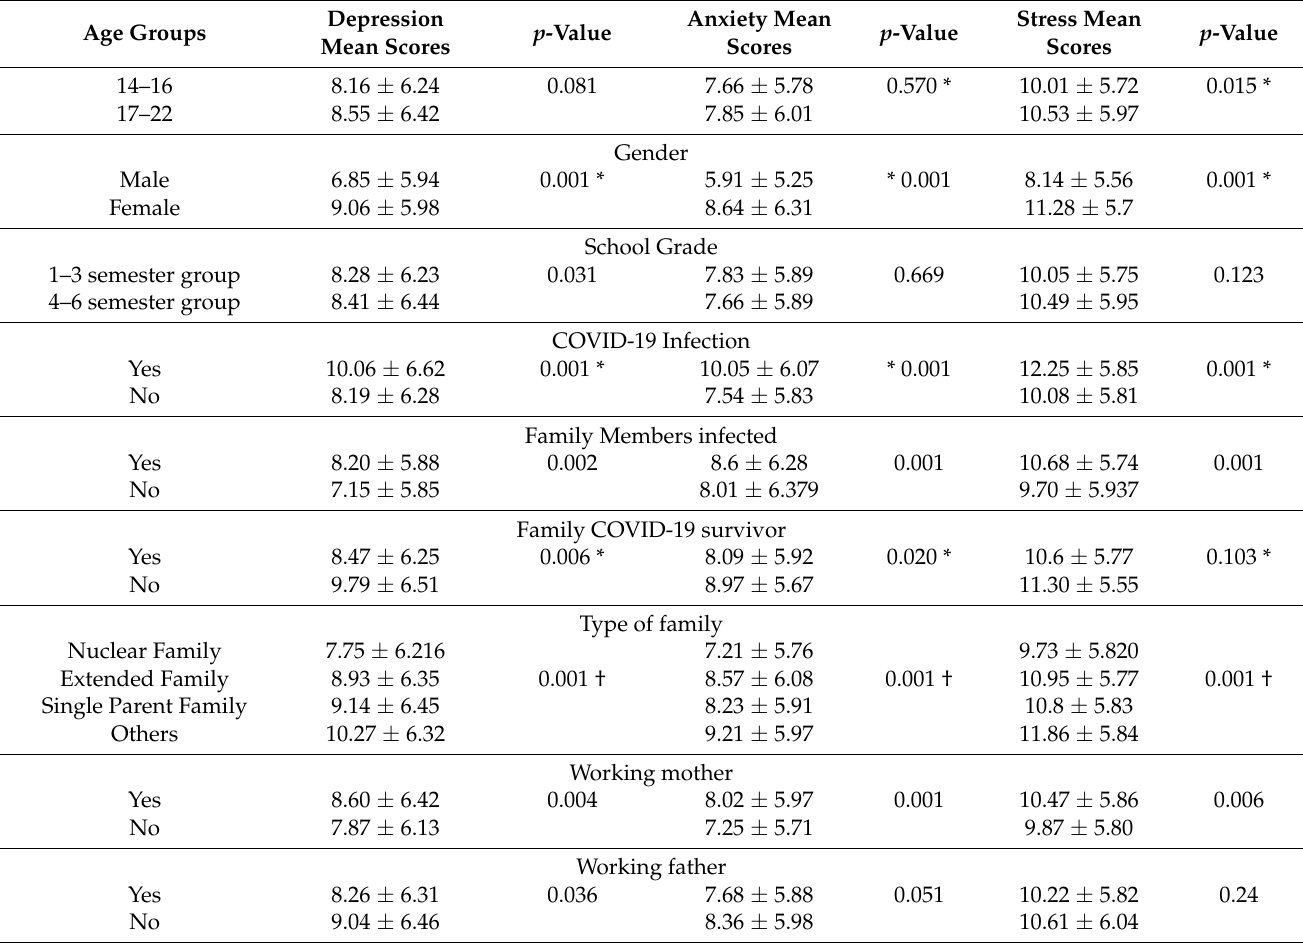
Table 3. DASS-21 mean scores categorized by age groups, gender, scholar shift, and family characteristics.